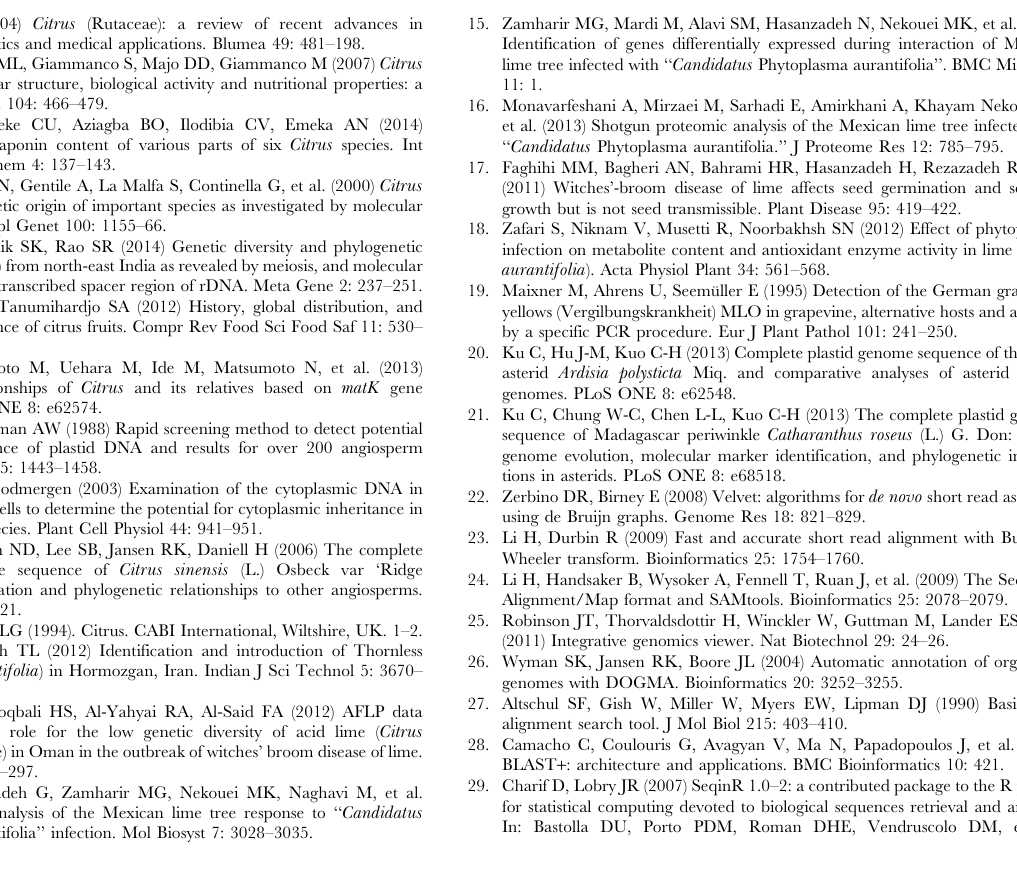
Figure S1 Alignment of the orf56 -containing sequences of two Citrus cp genomes and C. jambhiri mitochondrial ACRS sequences. (TIF) Figure S2 The maximum likelihood phylogeny of the cp orf56 and mt ACRS ORF sequences. Table S1 List of the complete chloroplast genome sequences included in the phylogenetic analysis. Table S2 List of the genes found in the C. aurantiifolia cp genome. Table S3 Codon usage of the C. aurantiifolia cp